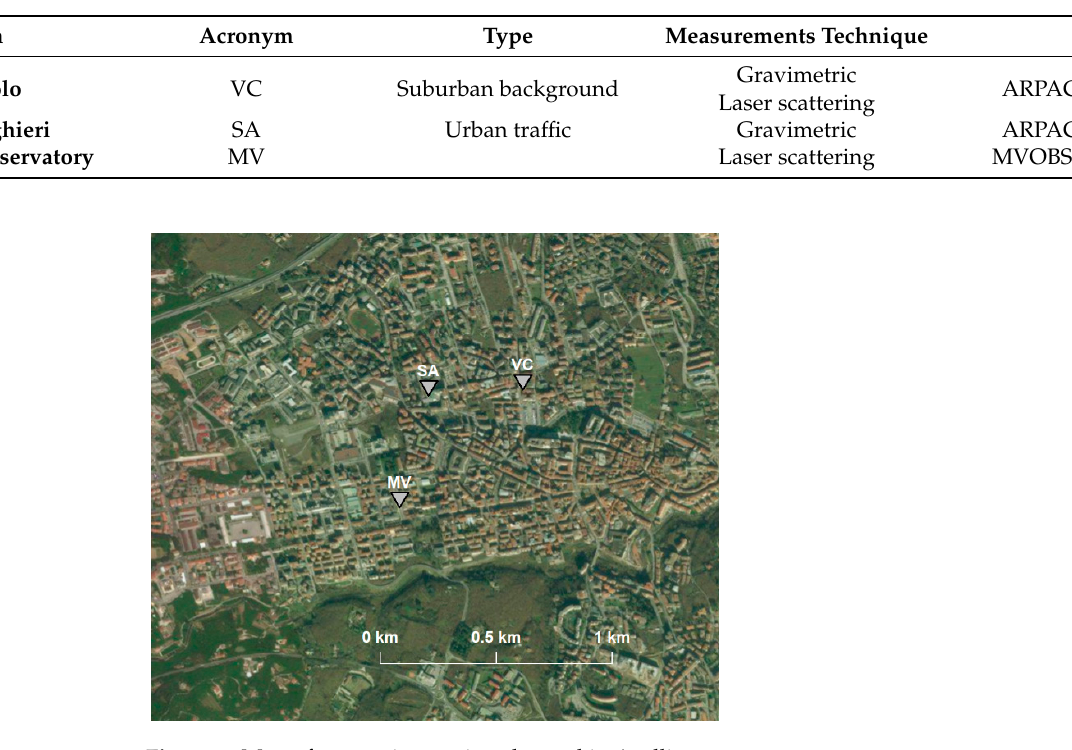
Table 1. Characteristics of the monitoring stations.